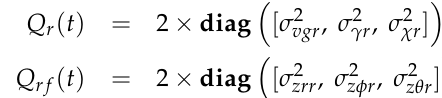
Table 3. Variances of process noises used in simulation (target).